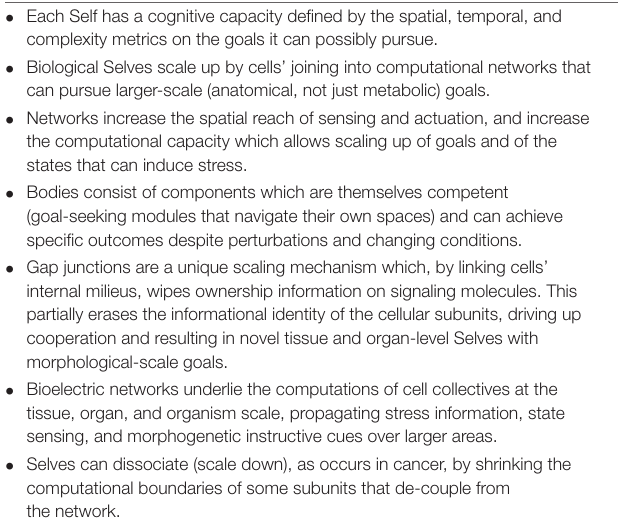
TABLE 3 | An example of the scaling of